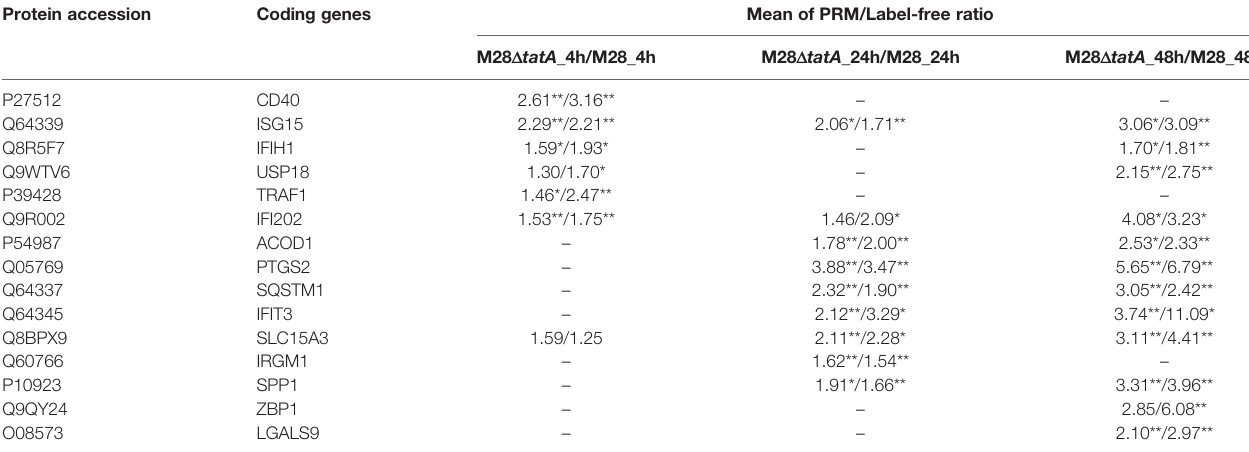
TABLE 1 | PRM validation of the proteomics. Protein accession Coding